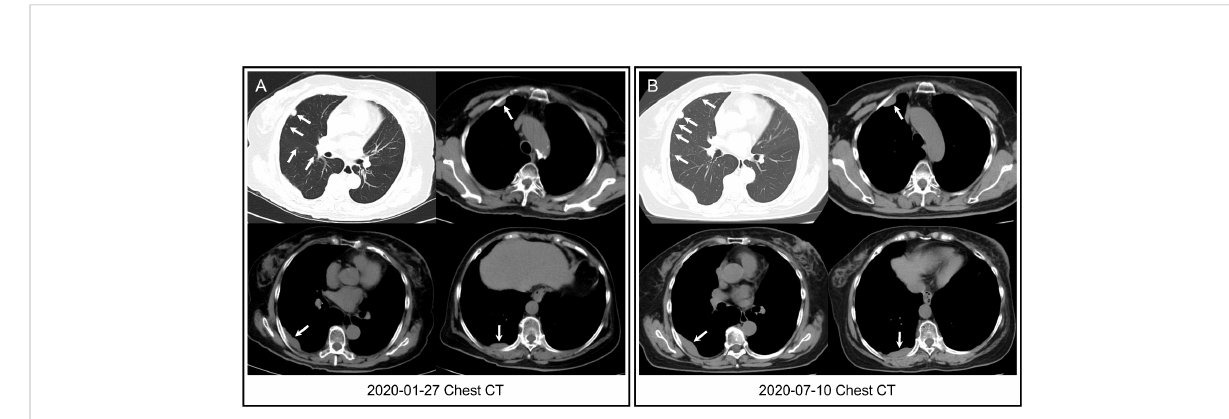
FIGURE 1 Chest CT. (A) Chest CT showed multiple pulmonary nodules in right lung and masses in right pleura (arrows) three years after surgery. (B) Followed-up chest CT revealed that pulmonary nodules increased in number, and pleural masses increased in size (arrows) when fi rst-line CDK4/6i + endocrine therapy was